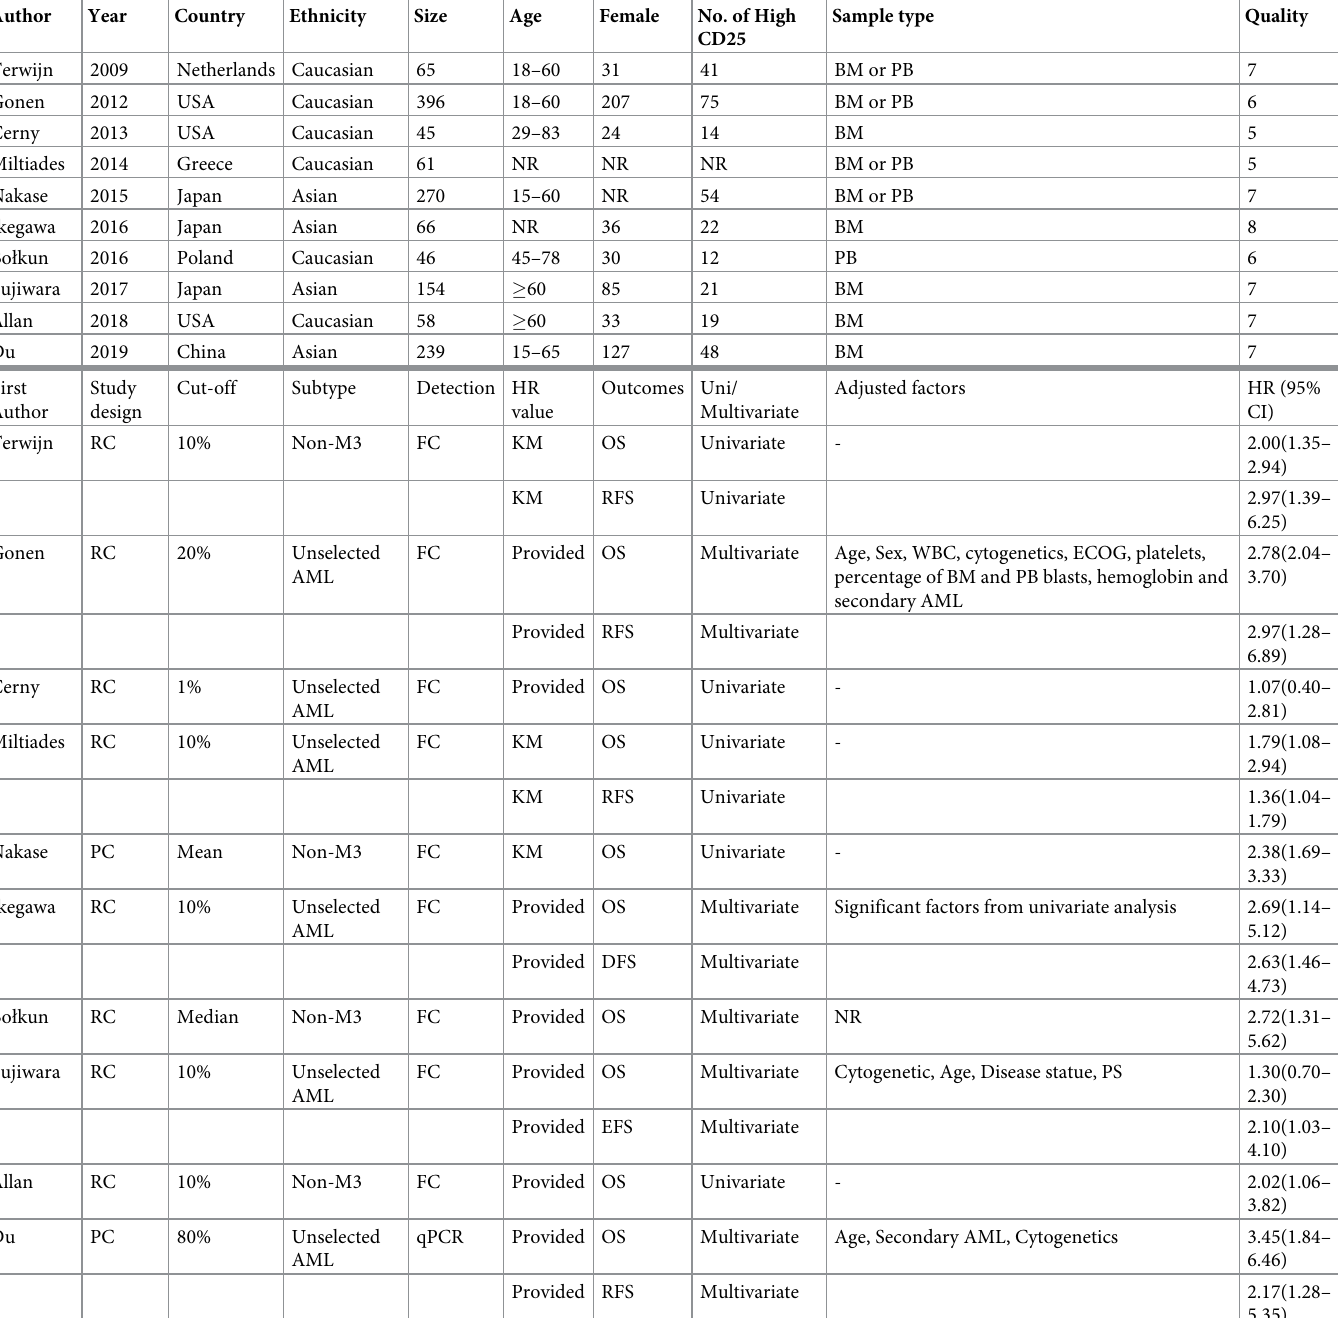
Table 1. A. Characteristics of studies included in the meta-analysis on CD25-related combination markers. B. The main features of the included studies for the prog- nostic